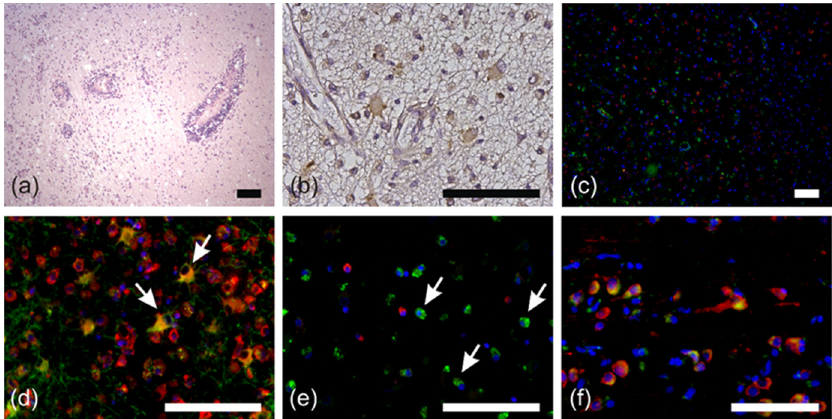
Figure 3. RPS27 staining in multiple sclerosis and encephalitis specimen. ( a ) H&E staining of the cerebellar inflammation in multiple sclerosis tissue. ( b ) RPS27-DAB staining in the cerebrum of multiple sclerosis tissue. ( c ) Immunofluorescence double staining for RPS27 (red) and astrocytes (GFAP = green) in the cerebrum of multiple sclerosis tissue. ( d ) Inflamed astrocytes with RPS27 (red) and GFAP (green) double positivity (arrows). ( e ) Immunofluorescence double staining for RPS27 (red) and macrophages (CD68 = green) in multiple sclerosis tissue. Arrows indicate CD68-positive but RPS27-negative cells. ( f ) Immunofluorescence double staining for RPS27 (red) and macrophages (CD68 = green) in encephalitis. DAPI = blue, scale bars = 100 µm.